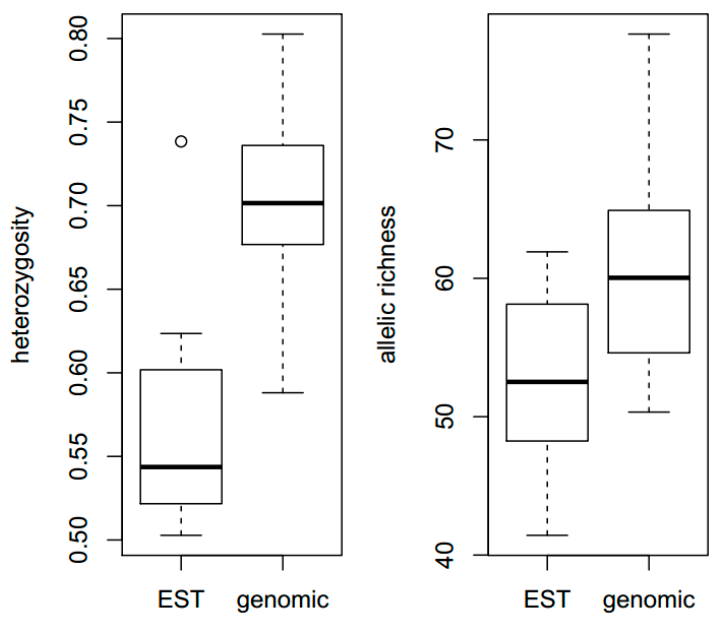
Figure A3. Box and whisker plots comparing heterozygosity and allelic richness between EST and genetic markers for the same species/samples.